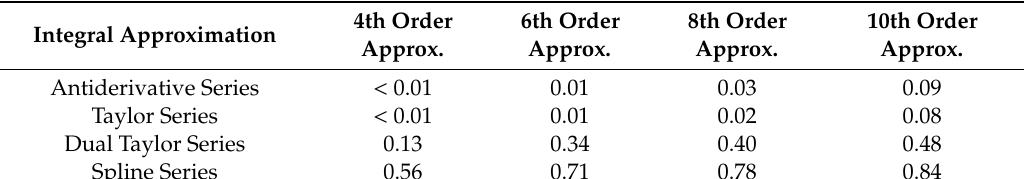
Table 4. Proportion of integral approximations, based on a set of 1000 test functions, with a relative error less than 0.01.